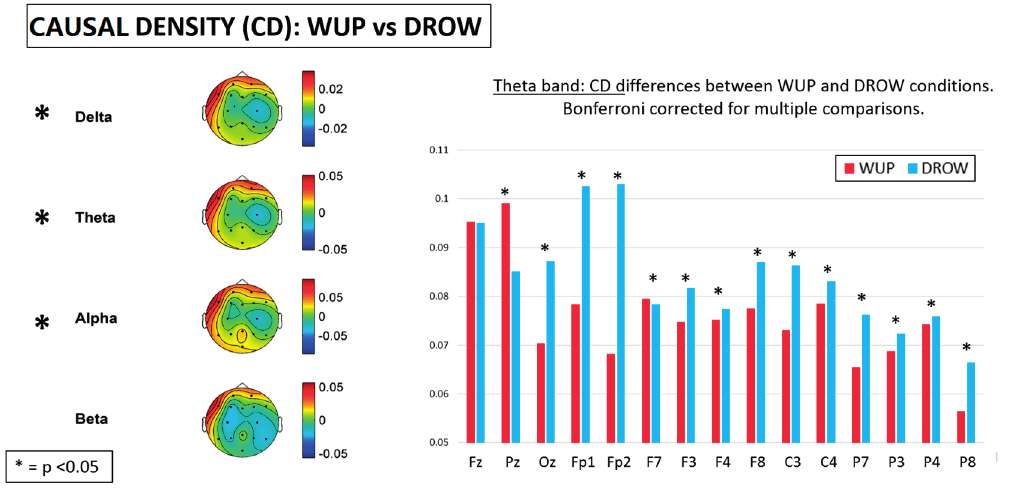
Figure 11. Differences of Causal Density (CD) between the WUP and DROWSY conditions. Significant differences were found in almost all EEG channels for the delta, theta and alpha bands. On the right side of the figure, the mean CD values in the theta band are reported as representative of the others. Note that, from WUP to DROWSY condition, CD significantly ( p < 0.05) increased over almost all EEG